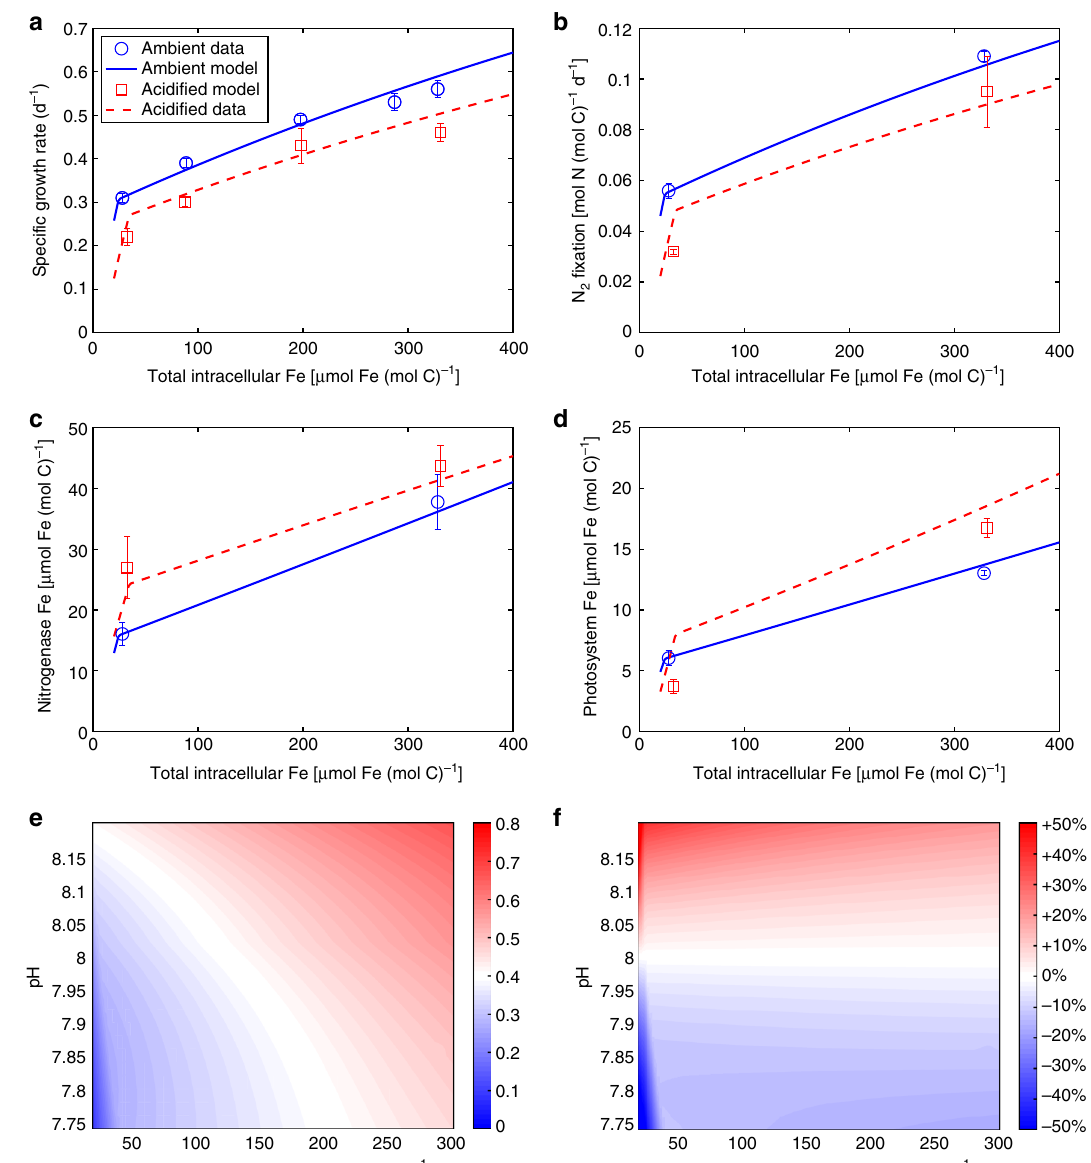
Fig. 3 Cellular model simulation results. a Speci fi c growth rate, b N 2 fi xation rate, c amount of Fe allocated to nitrogenase, and d amount of Fe allocated to photosystems under ambient (blue), and acidi fi ed (red) conditions, compared to the observations. e Growth rate and f the relative change of growth rate compared to that under pH 8.02 over ranges of seawater pH and intracellular Fe levels. For experimental data, error bars represent the s.d. of biological replicates ( n =